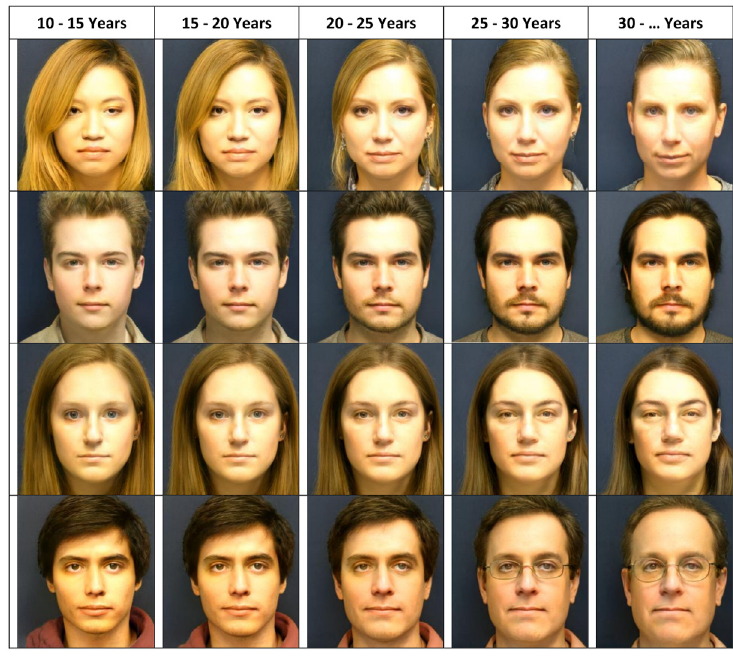
Figure 6. Model trained on F1L2M8 tested on Tufts face dataset sample set 2.